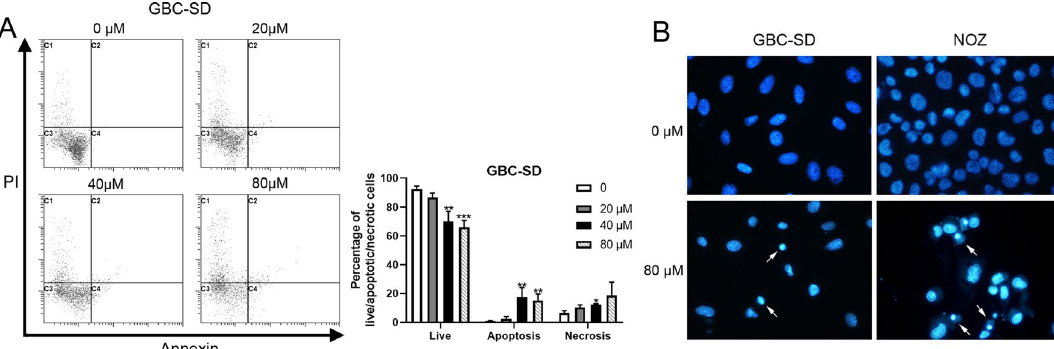
Figure 2. PTS increased apoptosis in human GBC cells. ( A ) The effect of PTS on the percentages of alive, apoptotic, and necrotic GBC-SD cells was evaluated by Annexin V/PI apoptosis assays. The mean values of the percentage of alive, apoptotic, and necrotic cells from independent experiments ± SD are presented. ( B ) Hoechst staining of GBC-SD and NOZ cells treated with PTS for 48 h. White arrows highlight apoptotic cells. * P < 0.05; ** P < 0.01; *** P < 0.001, compared with the control